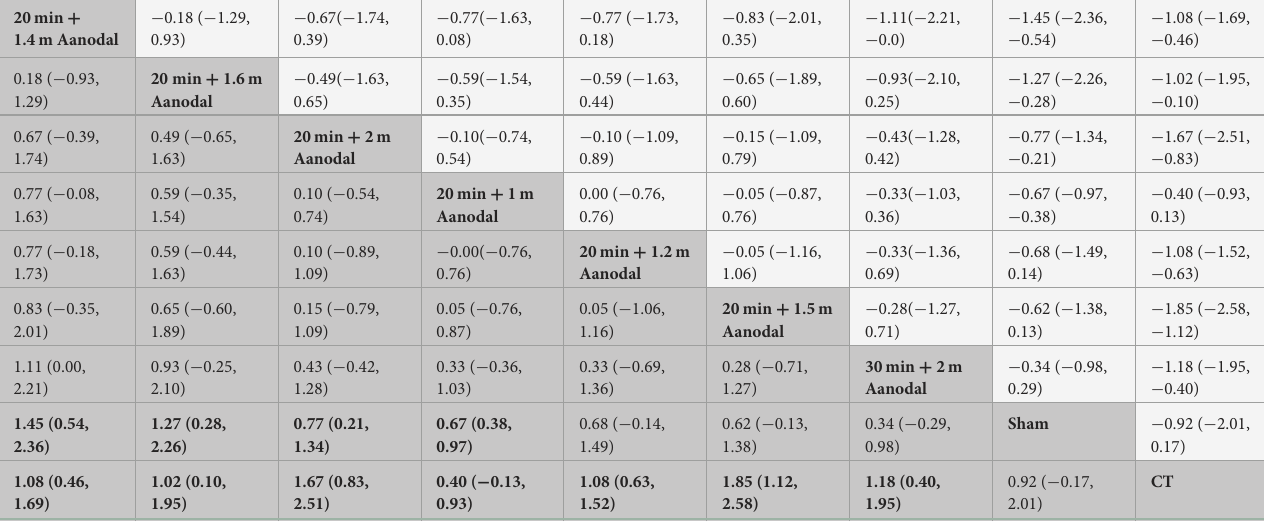
TABLE 2 Network meta-analysis of various interventions. 20min + 1.4m